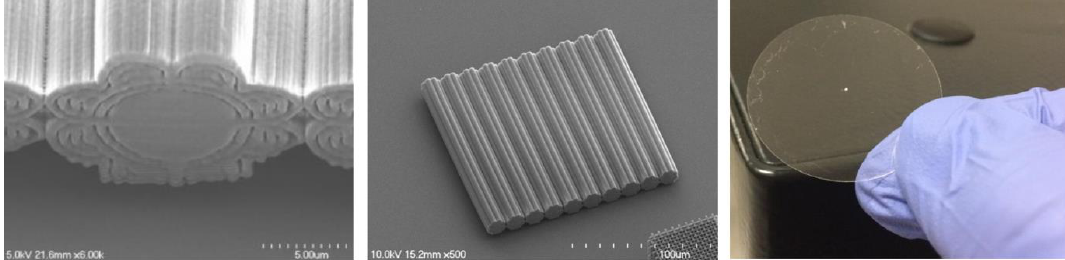
Figure 3. Series of images of a material prototype fabricated at 15 um scale that demonstrates a biomimicry design principle of structural color based on observations of blue haired tarantula [58].